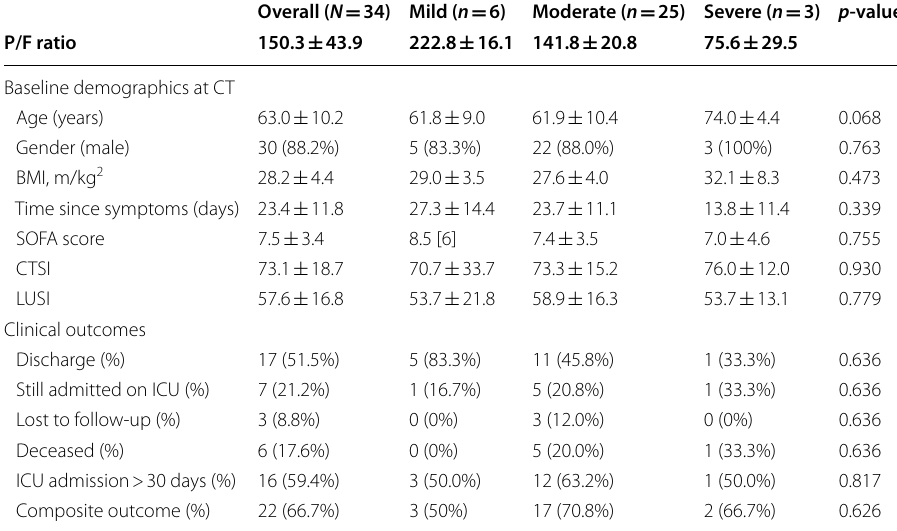
Variables were presented as means standard deviations ( SD), medians and interquartile range [IQR], or numbers ± ± (percent %) depending on distribution BMI body mass index, CT chest tomography, CTSI chest computed tomography severity involvement index, ICU intensive care unit, LUSI lung ultrasound score involvement, P/F ratio between partial oxygen pressure and fraction of inspired